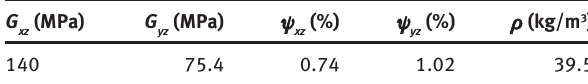
Table 5: Aluminium honeycomb core elastic and damping data [5].